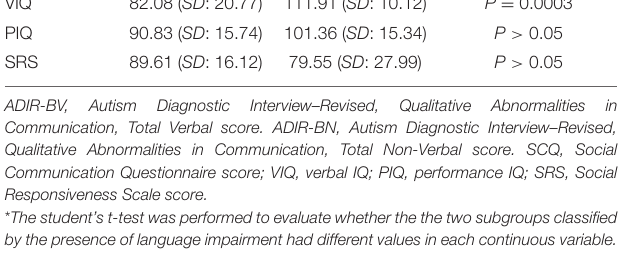
the association results ( Supplementary Figure 1 ). We selected 54 of them with a fold-change > 2 for the pathway